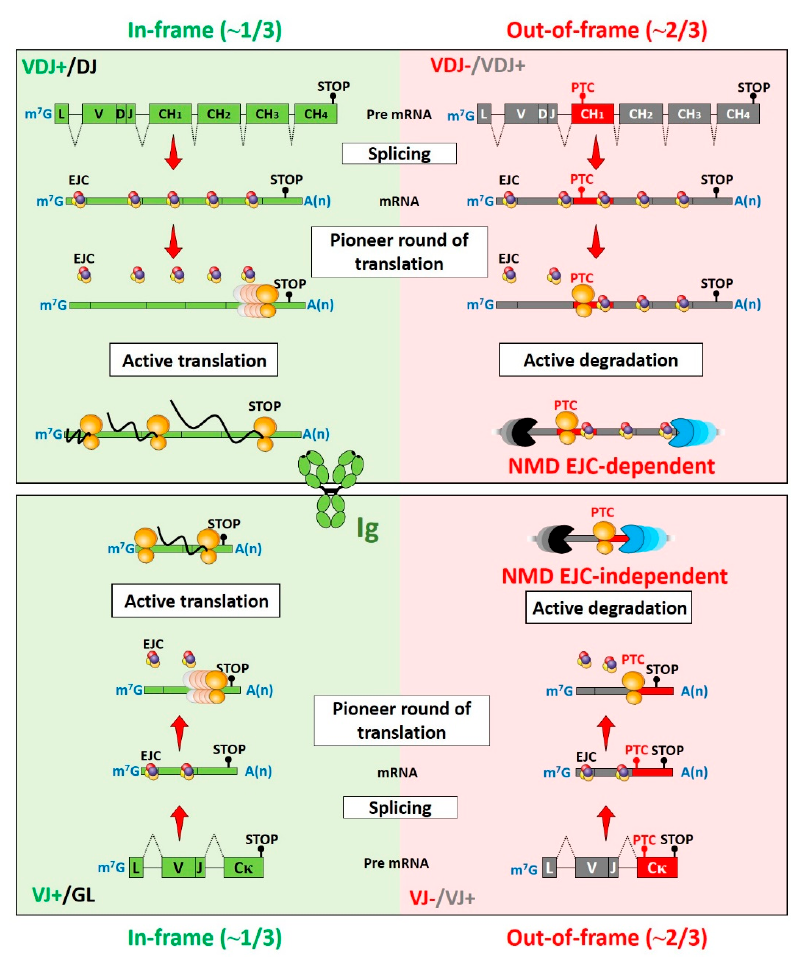
Figure 1. NMD pathways involved in the degradation of nonproductive Ig mRNAs. A multi-protein exon junction complex (EJC) is deposited 20–24 nucleotides upstream of each exon–exon junction during splicing of most transcripts. These EJCs remain associated with mRNAs until the first